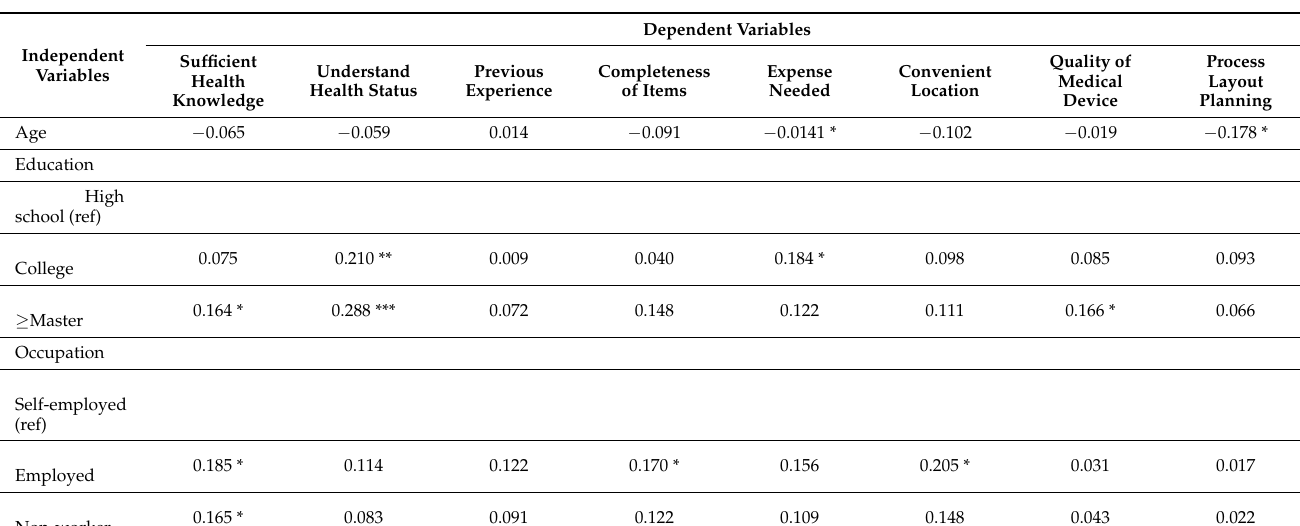
Table 4. Regression analysis based on participant characteristics, health status, and the items in Quadrant II of the importance–performance gap analysis